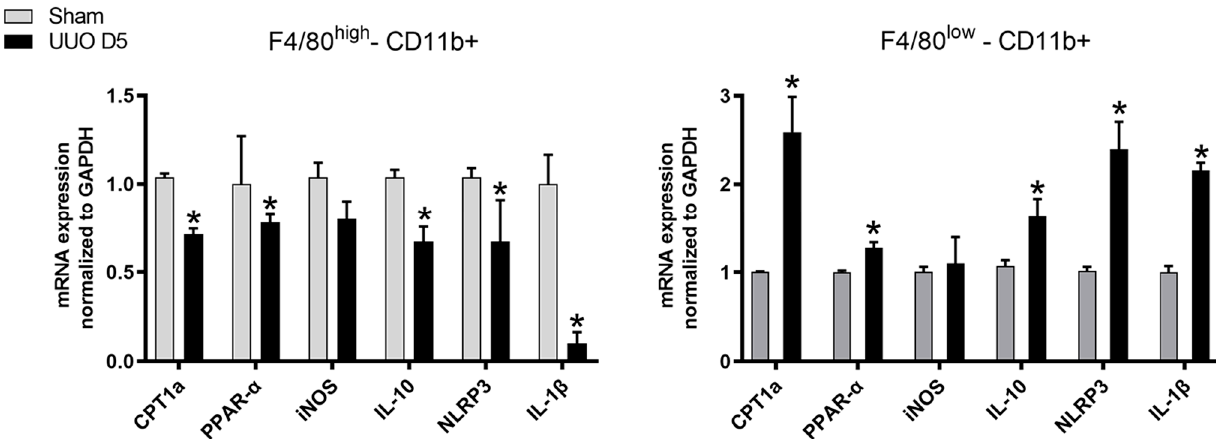
Figure 3. Gene expression profile of macrophages isolated from kidneys. Cells isolated from kidney tissue of sham operated and UUO-induced fibrotic mice at day 5 after obstruction characterized by flow cytometry. mRNA levels of CPT1a, PPAR- α , IL-10, iNOS, NLRP3 and IL-1 β from sorted macrophages measured by qPCR. Levels of mRNA were normalized to those of GAPDH and expressed as fold change. Data presented as mean ± SEM; n = 4 per group from three independent experiments; * p < 0.05 vs. sham.